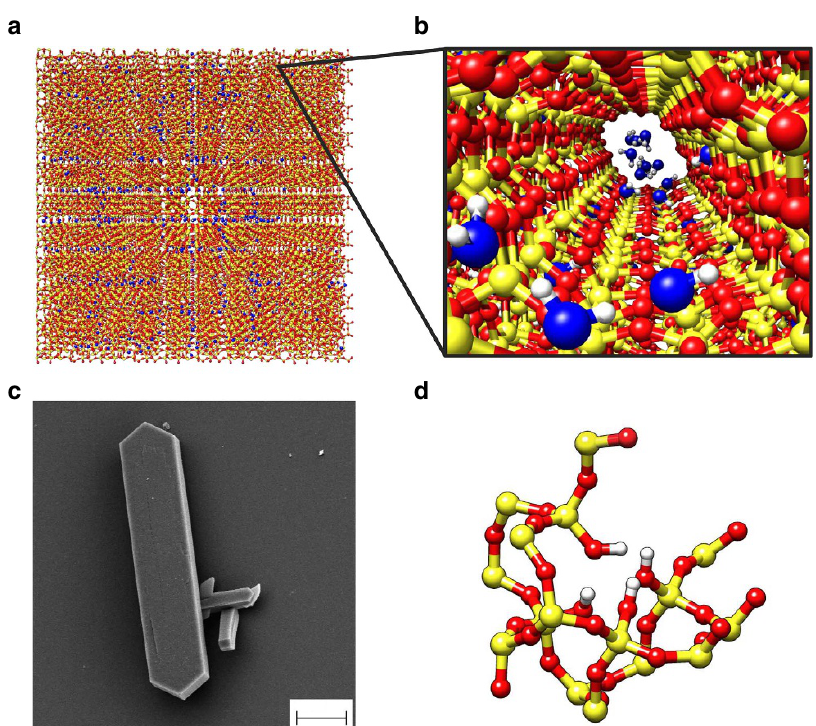
Figure 1 | MD and experimental specimens of zeolite. ( a ) Periodic silicalite-1 crystal (red/yellow) infiltrated by water molecules (blue) for a studied MD setup. ( b ) Detail of the water intrusion in a silicalite-1 pore. ( c ) Scanning electron microscopy analysis of a silicalite-1 crystal (scale bar, 10 m m). ( d ) ‘Silanol nests model’ of the hydrophilic defects induced by Al insertion in the silicalite-1 framework (silicon atoms are yellow; oxygen red; hydrogen white) 30 . Rendering MD pictures are made with UCSF Chimera 68 .